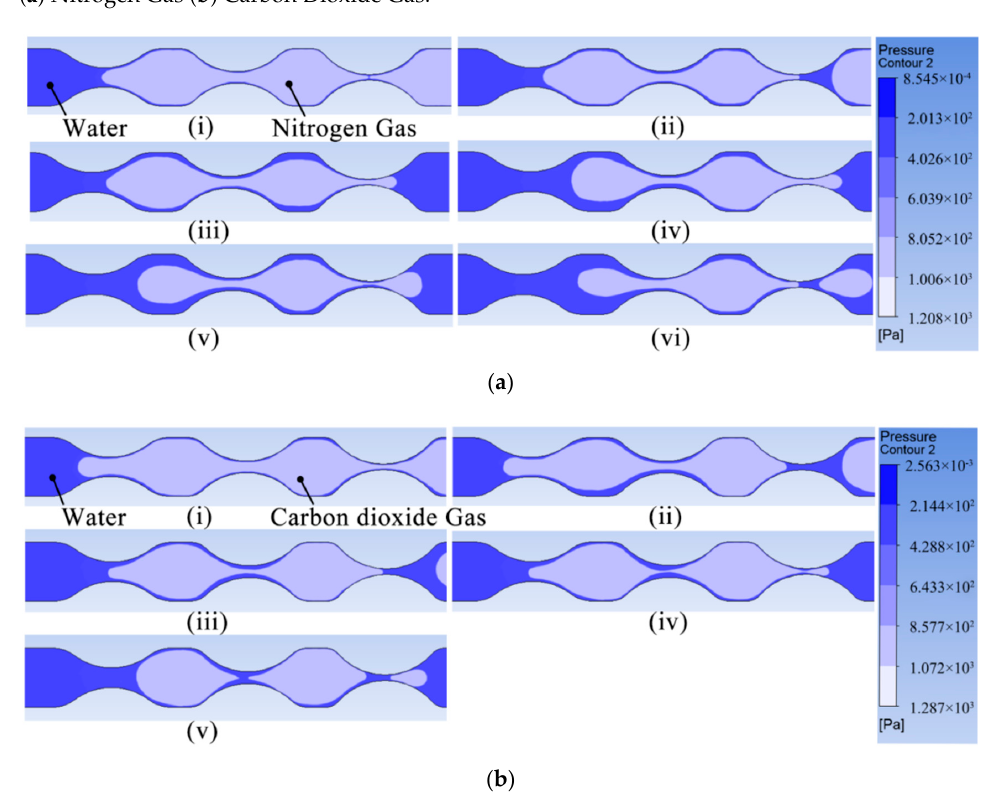
Figure A2. Pressure Contour (Pa) from Numerical Simulation for Continuously Tapering Pore Throat: ( a ) Nitrogen Gas, ( b ) Carbon Dioxide Gas.